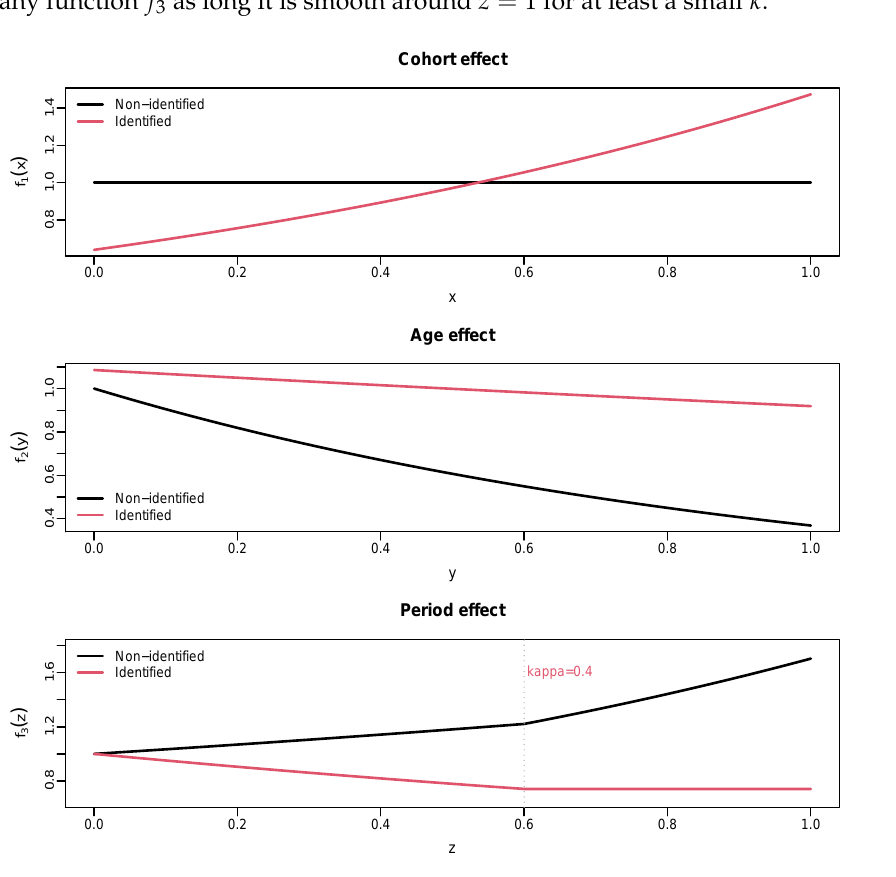
Figure A1. Illustration of how the identification works in an example. The log-linear trend of f 3 in the interval [ 1 − κ ,1 ] is removed and allocated into the components f 1 and f 2